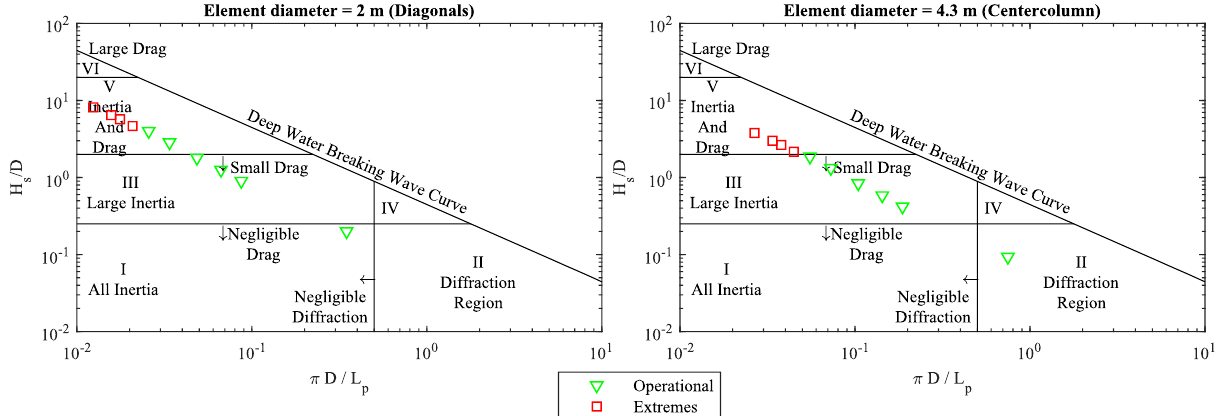
Figure 2. Sea states plotted against the dominating load regimes as defined in [20,34] for the most slender element ( left ) and the largest ( right